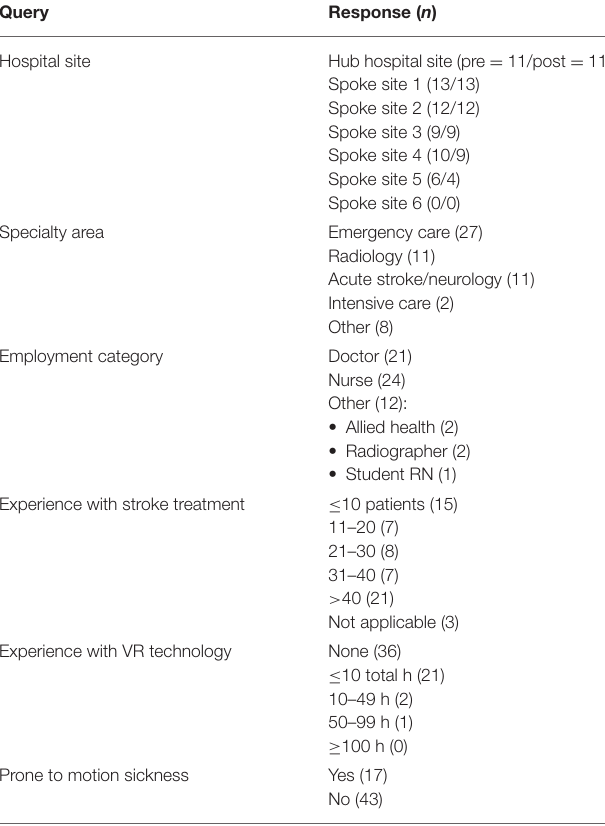
TABLE 2 | Survey respondent